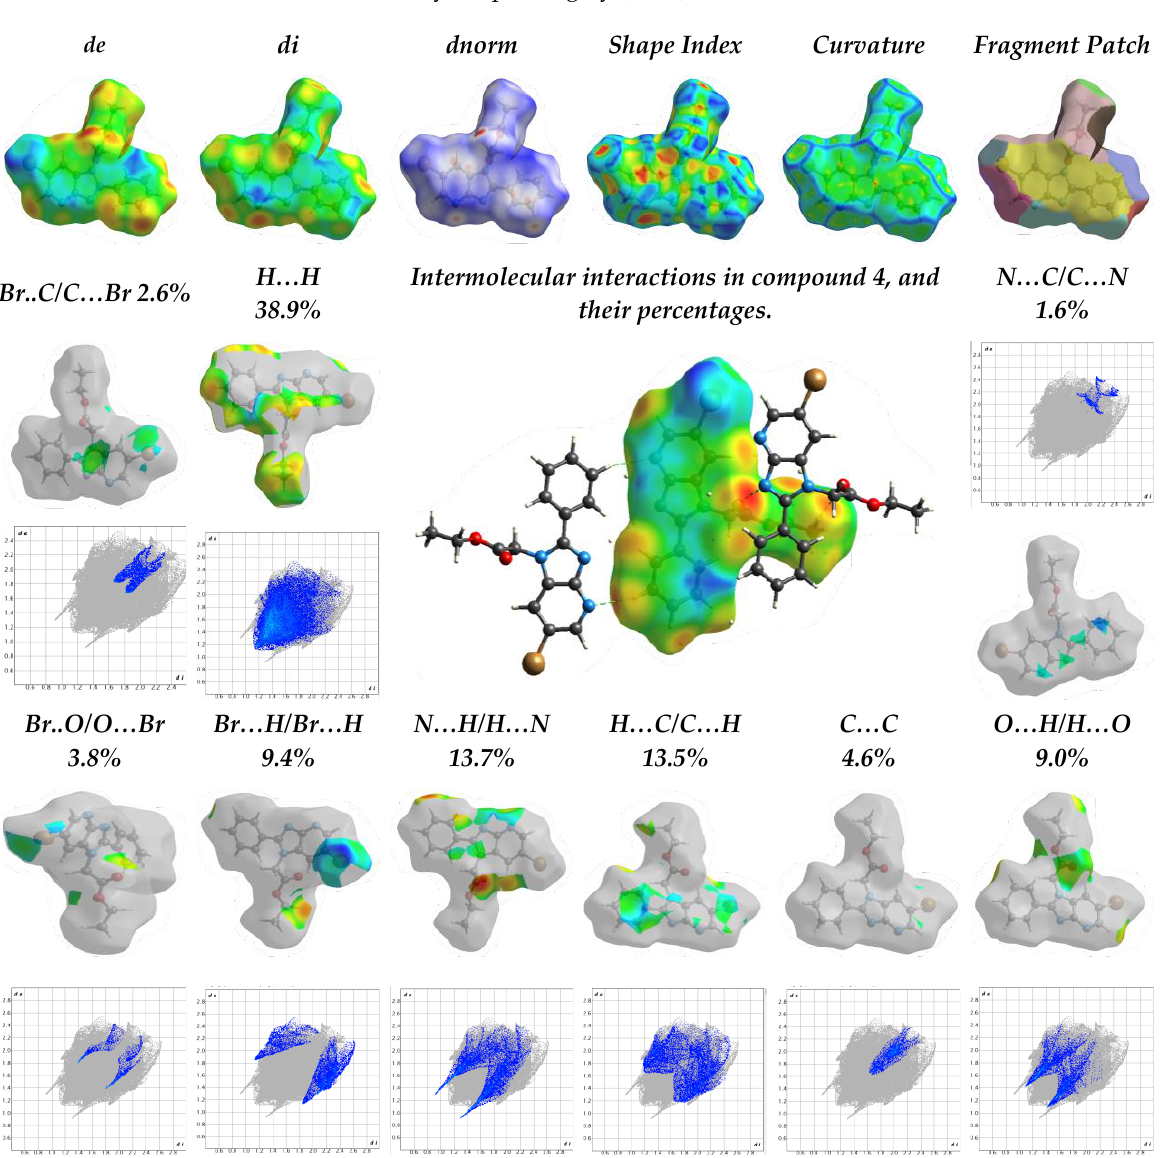
Figure 5. The HFM 2D interaction diagrams and their contribution in compound 8, as represented in the d norm , d i , d e , shape index “si” , curvedness “crv” and fragment batch “fb” . Si is a sensitive indicator of any lattice shape deviation (Figures 3–5). Red triangles are used to symbolize the concave region, which was located on the particle’s upper plane, indicating 6-bromo-2-phenyl-3H-imidazol outside of the surface for 3 , 6 and 8 . The triangles with blue highlights show the location of the phenyl fragment on the superficial exterior. SI data were in agreement with the 2D pattern. The morphology for the particles’ surface for 3 , 6 and 8 was studied, together with the crv fingerprint, which separated into dual patches of curvature due to the connections between nearby molecules.